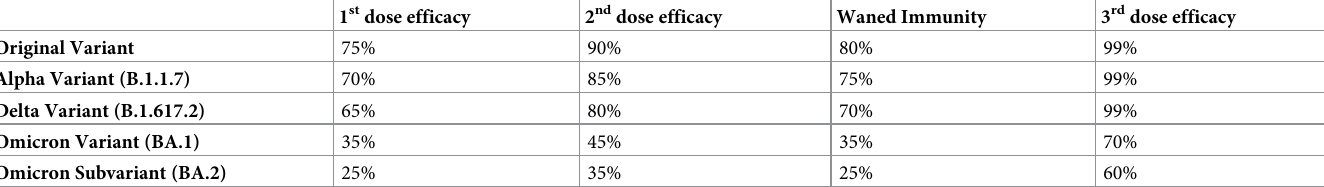
Table 1. Vaccine efficacies used in the simulations.